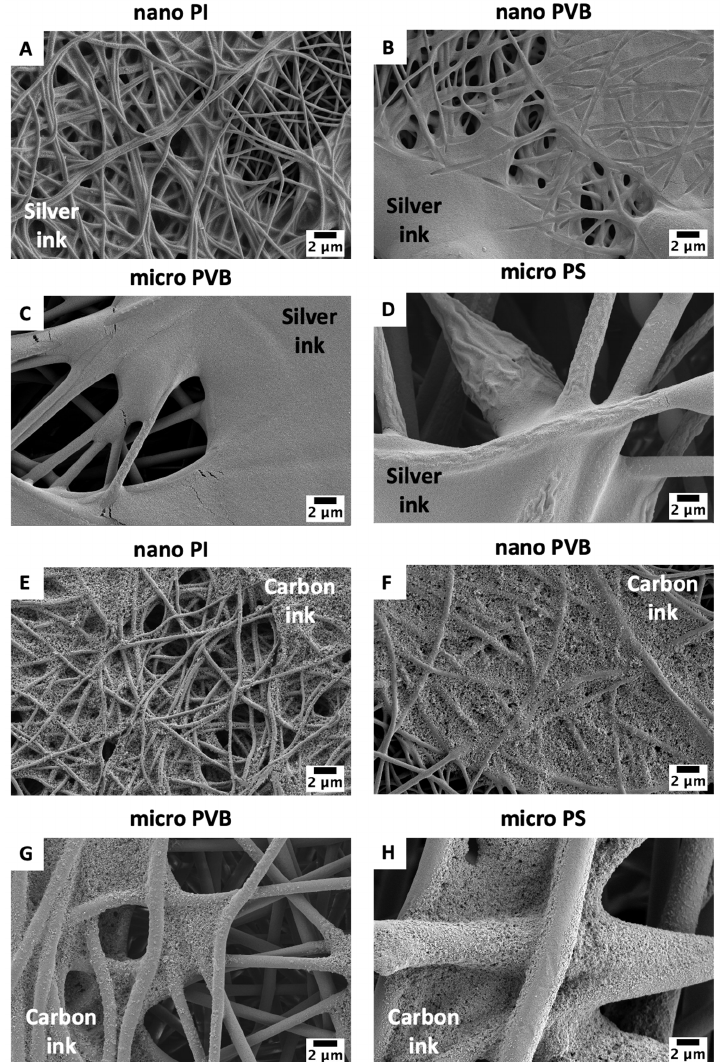
Figure 4. SEM micrographs of electrospun membranes: ( A , E ) nano PI and ( B , F ) nano PVB, ( C , G ) micro PVB and ( D , H ) micro PS printed with two layers of silver and carbon ink, respectively. All pictures were taken after sample sintering.